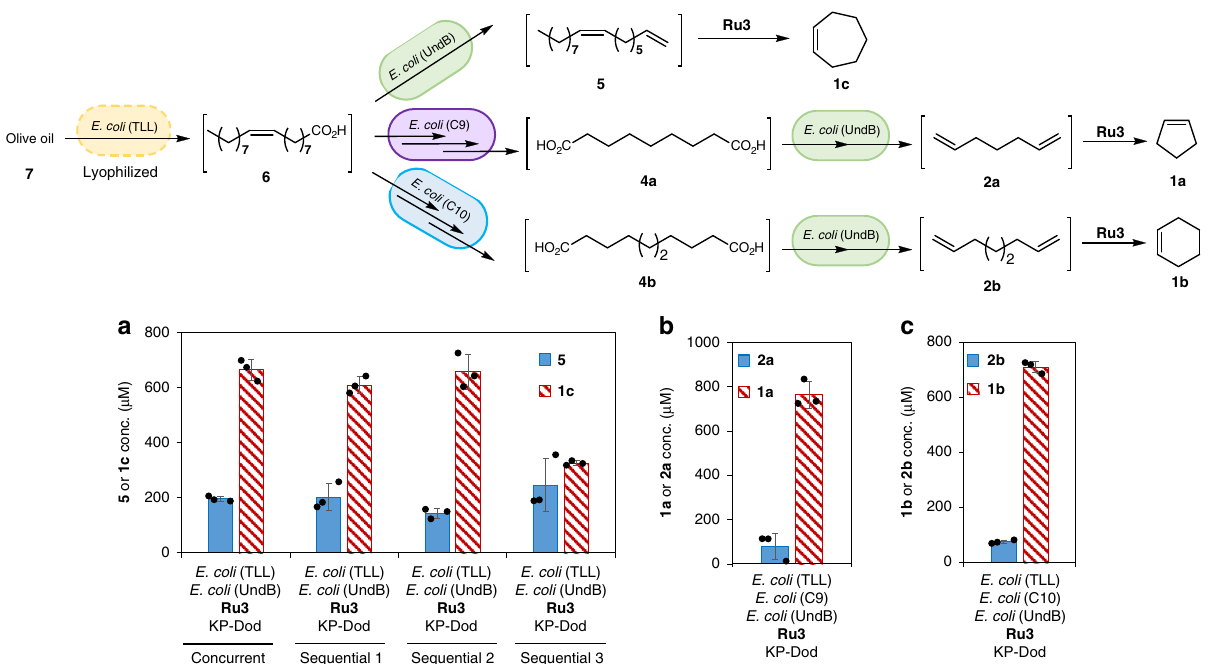
Fig. 8 Chemo-enzymatic cascades for the conversion of olive oil ( 7 ) to cycloalkenes ( 1a - 1c ). a One-pot conversion of olive oil ( 7 ) (1 g l − 1 ) to cyclopentene ( 1a ) with E. coli (TLL) (1 g l − 1 ), E. coli (UndB) (10 g l − 1 ) and Ru3 (100 μ M) in KP buffer (200 mM, pH 8.0, 1% glucose) in the presence of n -dodecane (10%) at 30 °C for 24 h. Sequential 1: Ru3 was added after 2 h (total reaction time: 24 h). Sequential 2: E. coli (UndB) and Ru3 were added after 2 h (total 24 h). Sequential 3: E. coli (UndB) was added after 2 h, and Ru3 was added after 12 h (total 24 h). b One-pot conversion of 7 (1 g l − 1 ) to cyclopentene ( 1a ) with E. coli (TLL) (1 g l − 1 ), E. coli (C9) (10 g l − 1 , added after 1 h), E. coli (UndB) (10 g l − 1 , added after 12 h) and Ru3 (100 μ M, added after 12 h) in KP buffer (200 mM, pH 8.0, 1% glucose) with n -dodecane (10%, added after 12 h) at 30 °C for 24 h. c One-pot conversion of olive oil ( 7 ) (1 g l − 1 ) to cyclohexene ( 1b ) with E. coli (TLL) (1 g l − 1 ), E. coli (C10) (10 g l − 1 , added after 1 h), E. coli (UndB) (10 g l − 1 , added after 12 h) and Ru3 (100 μ M, added after 12 h) in KP buffer (200 mM, pH 8.0, 1% glucose) with n -dodecane (10%, added after 12 h) at 30 °C for 24 h. Source data are provided as a Source Data fi le. Data are mean values of triplicate experiments with error bars indicating standard deviations ( n =